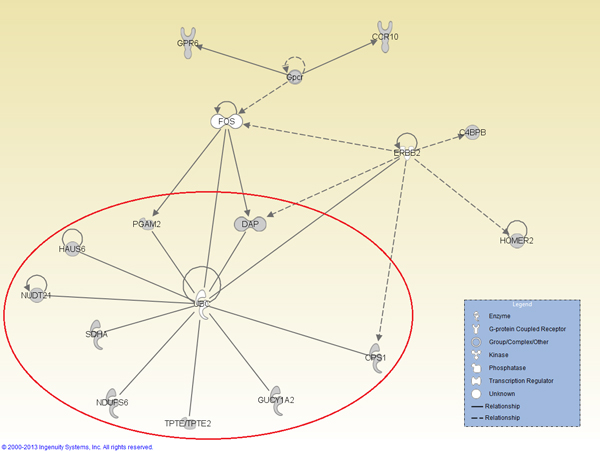
IPA network visualization of BiNets 52 and 228. A network found by analyzing the combined network of BiNets 52 and 228 using IPA. The sub network within the red circle is the UBC network whose survival test result is shown in Figure 4.